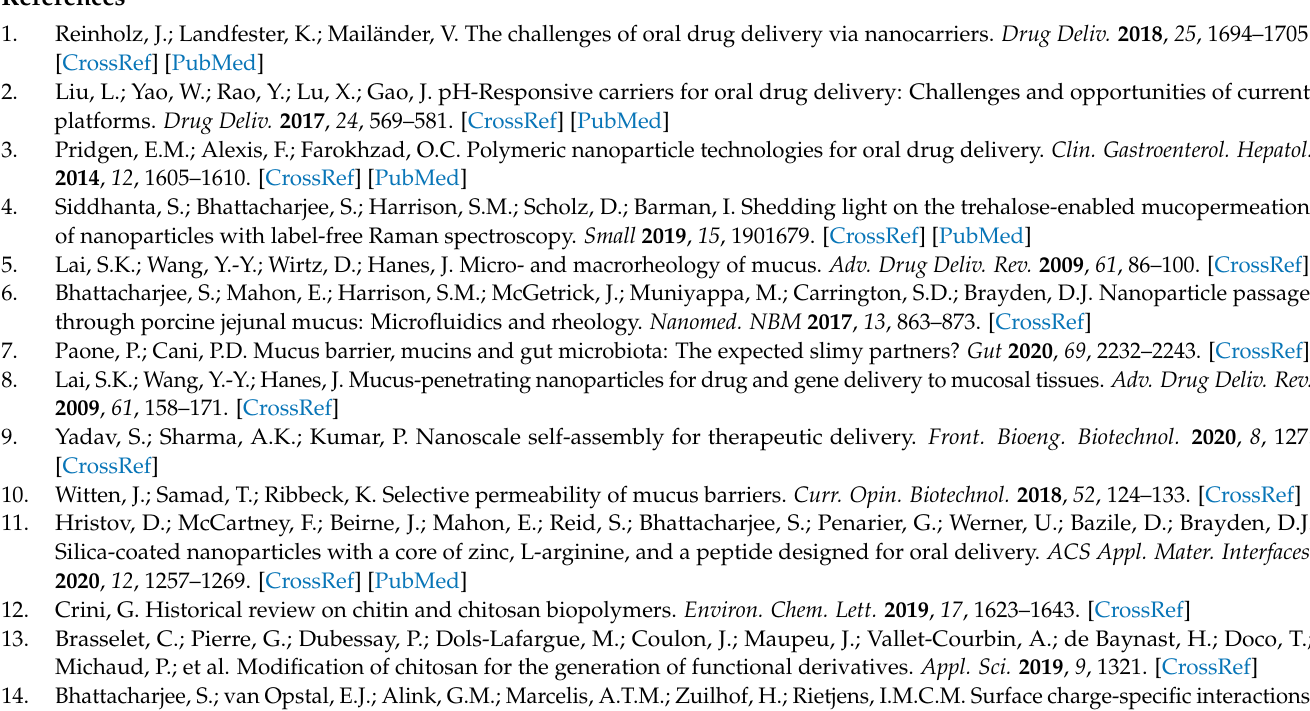
Figure S3: Stacked 1 H spectra of chitosan, mannose, and mannosylated chitosan; Figure S4: Entrap- ment efficiency of C6 in C6@CNCs and C6@M-CNCs; Figure S5: Brightfield and